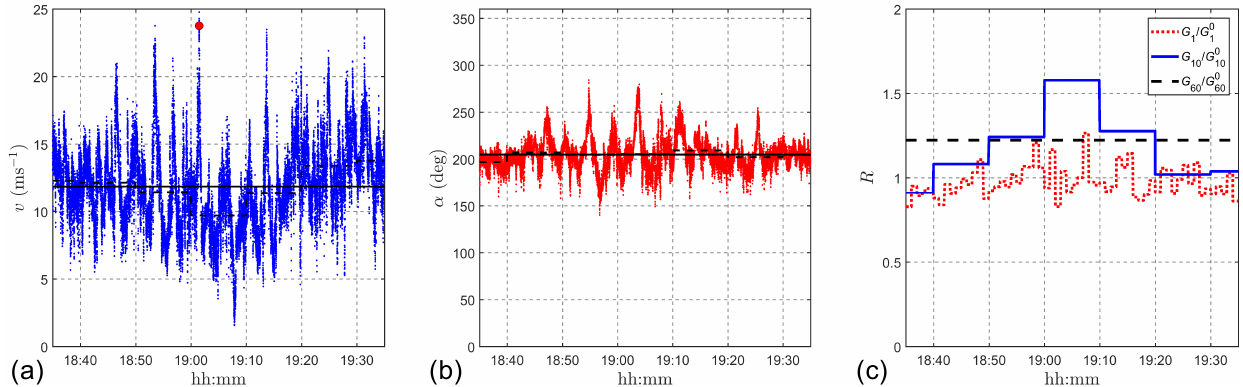
Figure 7. Intermediate event recorded on 10 October 2013 by the anemometer 3 of the port of La Spezia: (a) 1h wind speed time-series; (b) wind direction time-series; and (c) ratio of gust